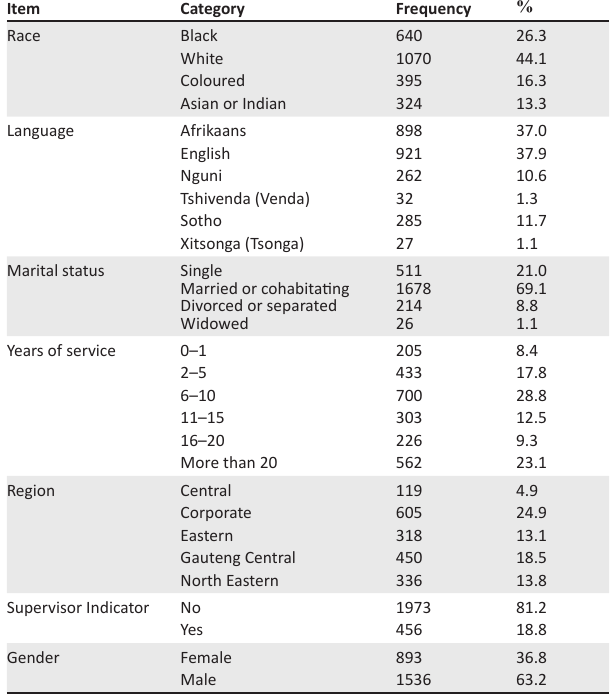
TABLE 1: Biographical and demographical details of the participants ( n =